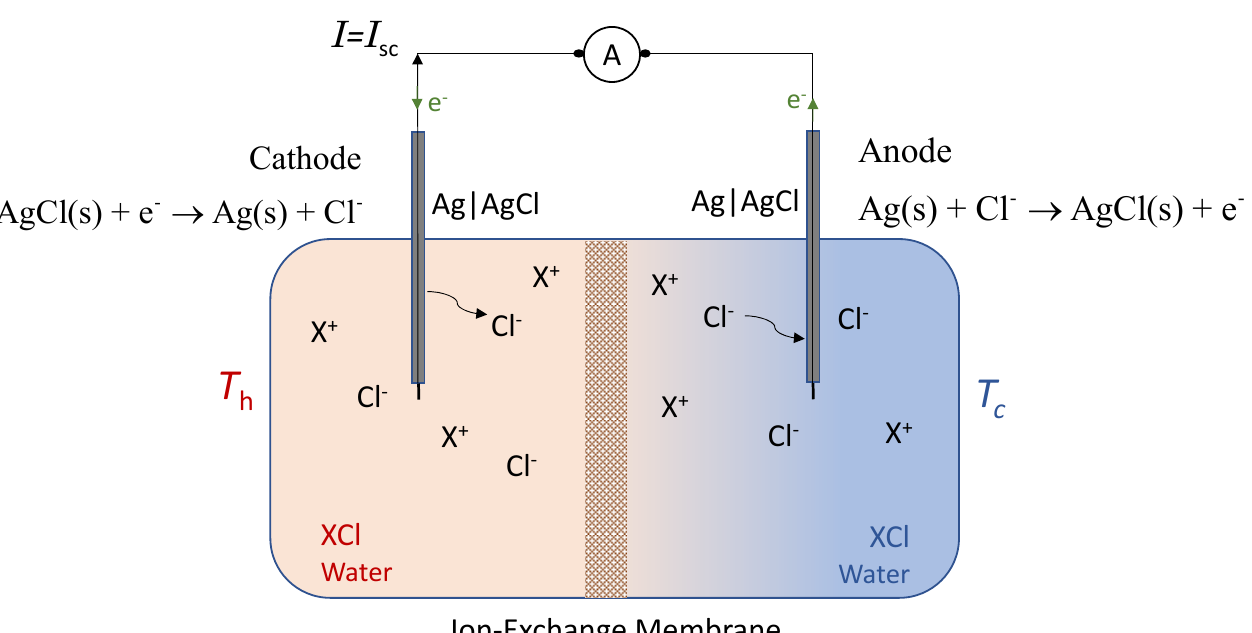
Figure 1. Schematic representation of a XCl-H 2 O thermocell with an ion-exchange membrane and Ag|AgCl electrodes in the short-circuit configuration. A: Amperemeter; I sc : Short-circuit current; T h : Hot temperature; T c : Cold temperature.